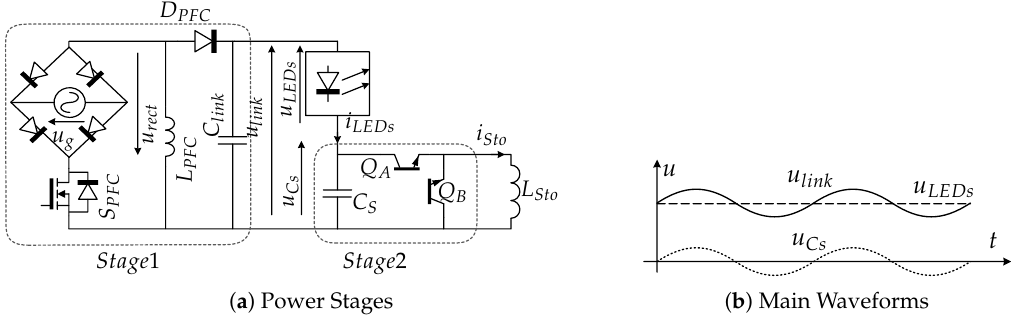
Figure 3. Proposed Circuit, with the input PFC stage and the output buck stage delivering energy back to the DC